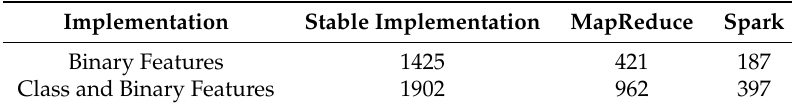
Table 7. Running time per implementation (in